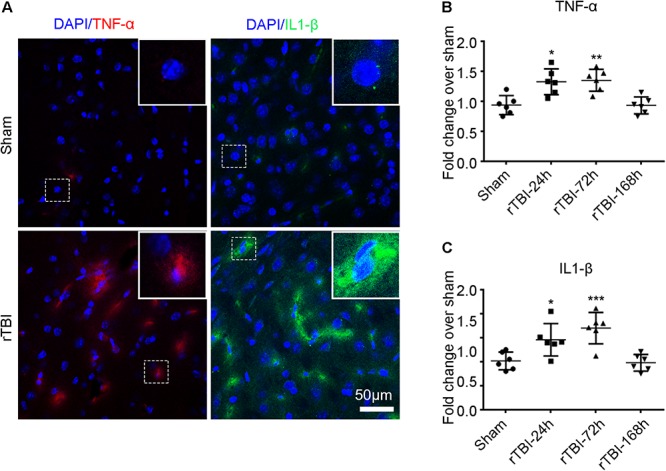
Repetitive traumatic brain injury (rTBI) increased proinflammatory cytokine levels. (A) Representative tumor necrosis factor (TNF)-α and interleukin (IL)-1β immunostaining for inflammatory cytokines in the brain stem between sham and rTBI groups at 24 h post injury. Bar graphs represent the mean ± SD percentage fold change in TNF-α (B) and IL-1β (C) levels in rTBI brain lysates compared to the levels in the sham brain lysates at the respective time points. For both graphs, ∗P < 0.05, ∗∗P < 0.01, and ∗∗∗P < 0.001 comparing rTBI versus sham, using one-way ANOVA and multiple t-tests with Dunnett’s corrections for multiple comparisons.